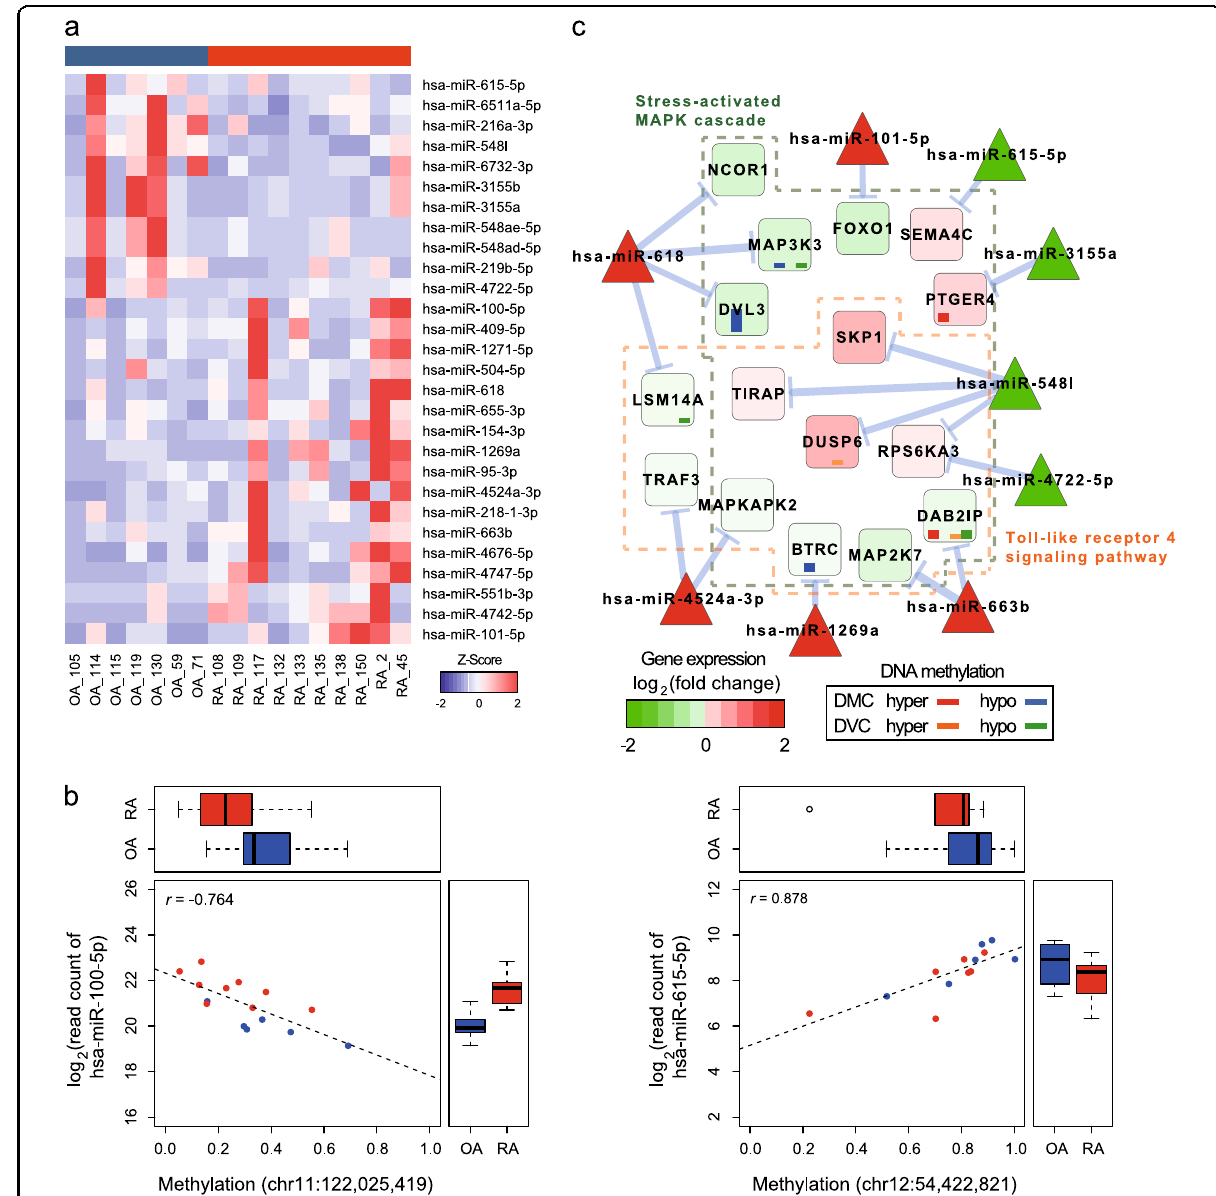
Fig. 5 Identi fi cation of differentially expressed miRNAs between RA and OA. a A heatmap with miRNAs identi fi ed as differentially expressed. Raw counts of the miRNAs were transformed into Z -scores and color scaled. b Scatterplots describe methylation in the single CpGs and miRNAs expression in individual samples. Box plots show methylation (top) and miRNA expression in each disease (right). c A subnetwork of microRNA – mRNA pairs. Colors in circles represent gene expression levels in RA relative to OA. Red is upregulated and green is downregulated. Blue arrows average negative correlations. Inner bar plots represent the number of DMCs or DVCs in certain genes. DMCs are colored red (hypermethylated) and blue (hypomethylated), while DVCs are colored orange (hypervariable) and green